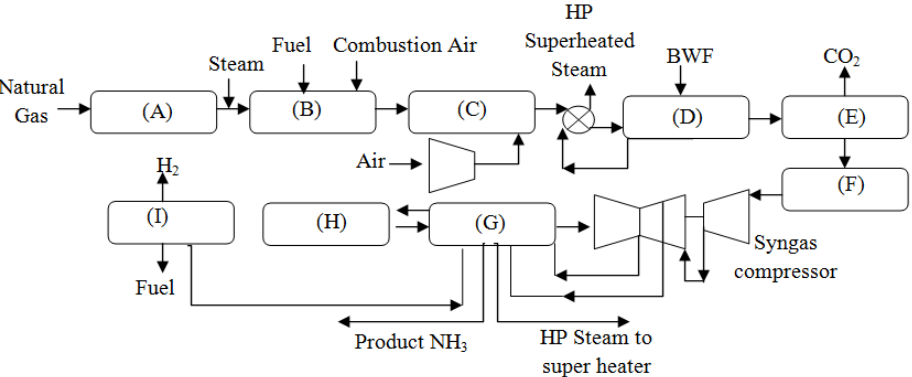
Figure 2. Block diagram of conventional NH 3 production, reproduced from the reference [8]. (A) Desulfurization (B) Primary Reformer (C) Secondary Reformer (D) CO shift (E) CO 2 removal (F) Methanation (G) NH 3 loop (H) Refrigeration (I) NH 3 Loop.